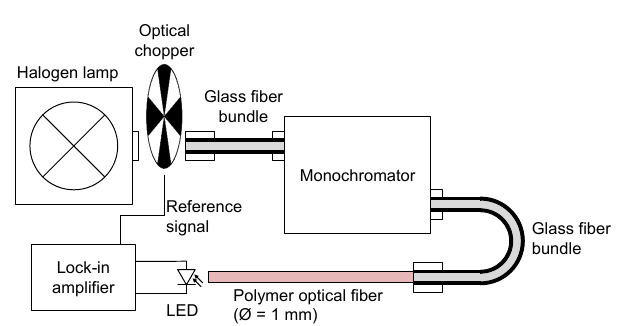
Figure 8. Measurement setup for the determination of the spectral responsivity of the